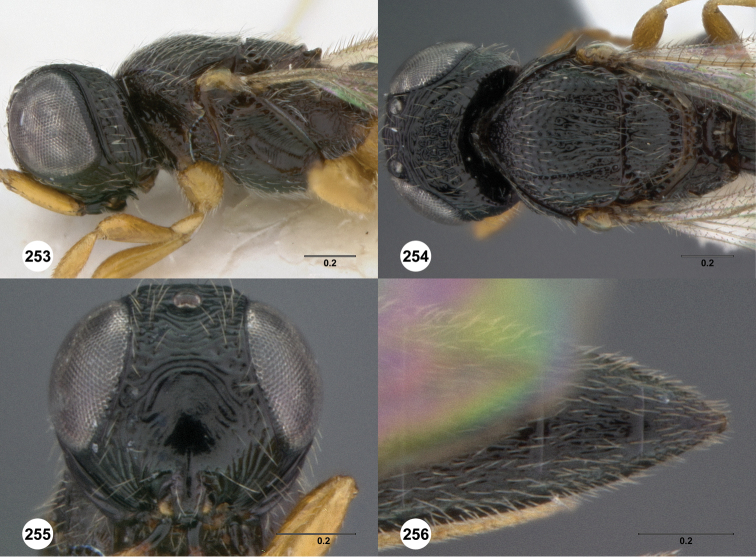
Oxyscelio pectinis sp. n., paratype female (OSUC 449001) 253 Head and mesosoma, lateral view. Holotype female (OSUC 368207) 254 Head and mesosoma, dorsal view 255 Head, anterior view 256 Metasoma, dorsal view. Morphbank76